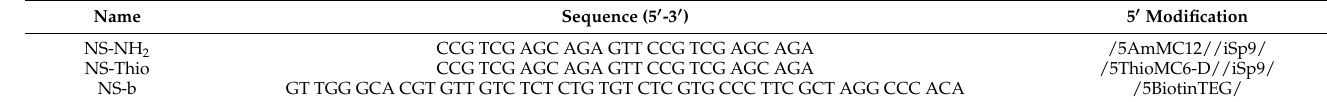
Table 2. List of nonsense (NS) aptamers. All modifications are referred to the standard nomenclature of the